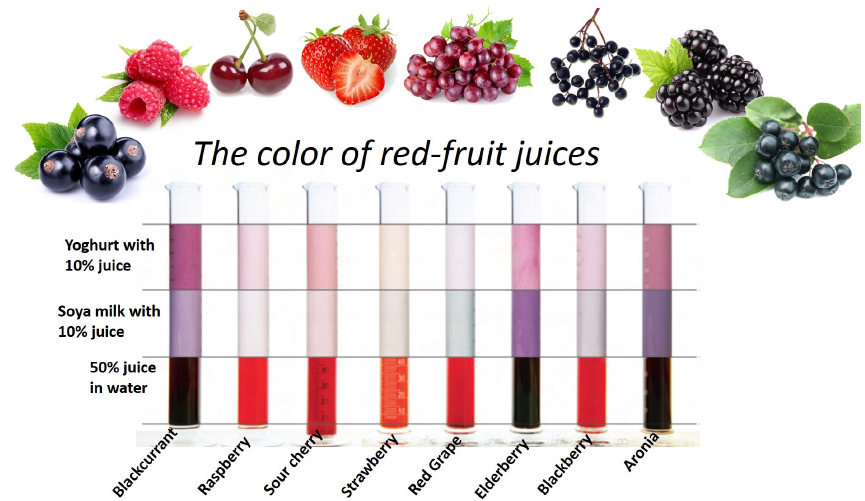
Figure 2. The color of different flavored juices made with 90% yoghurt, 90% soy milk and 50% water, as a reaction to pH and/or presence of protein. Adapted from [49].